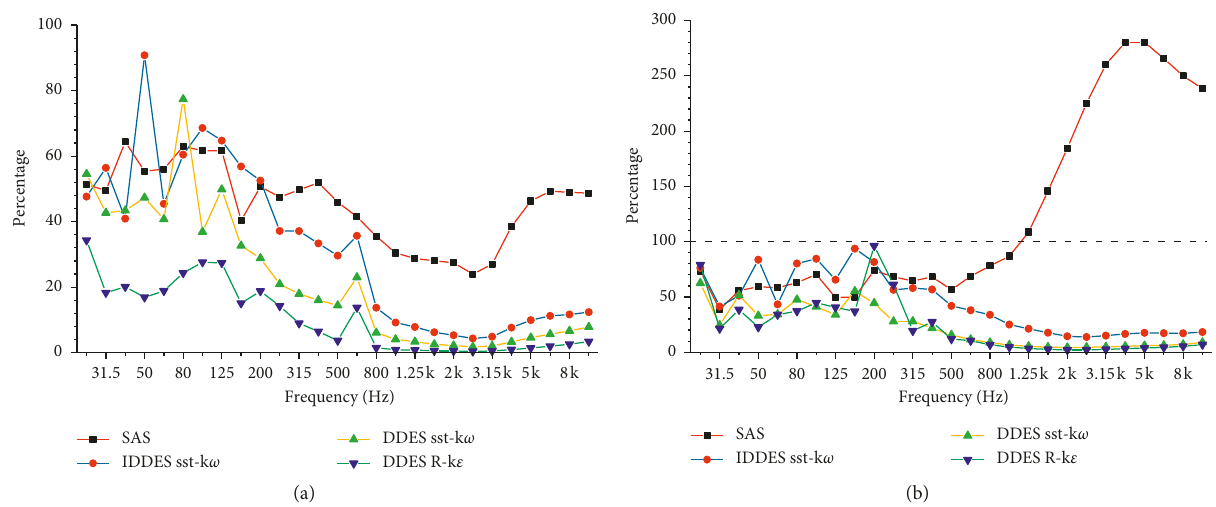
Figure 15: Percentage of W of the four models at all frequencies relative to LES (350km/h): (a) whole pantograph and (b) bottom frame source area. The dashed line represents the result from LES.